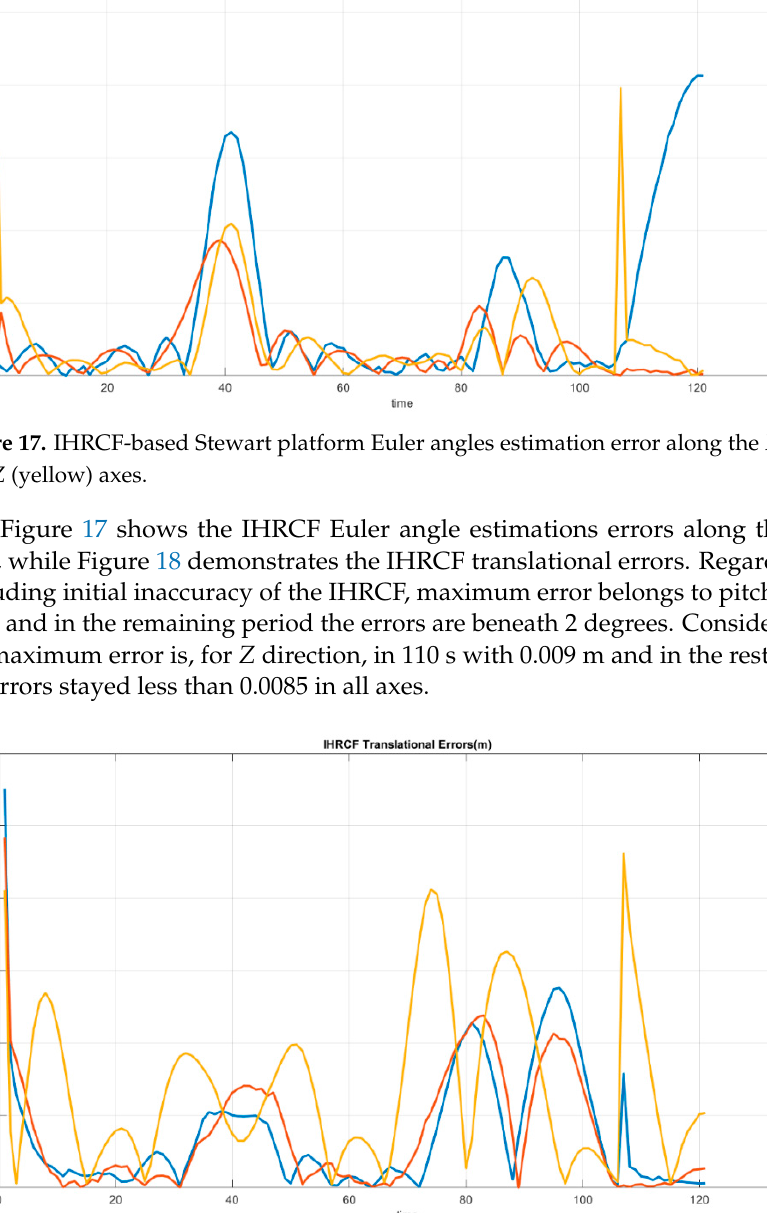
Figure 18. IHRCF translational pose estimation errors for the Stewart platform along the X (blue), Y (red), and Z (yellow) axes.